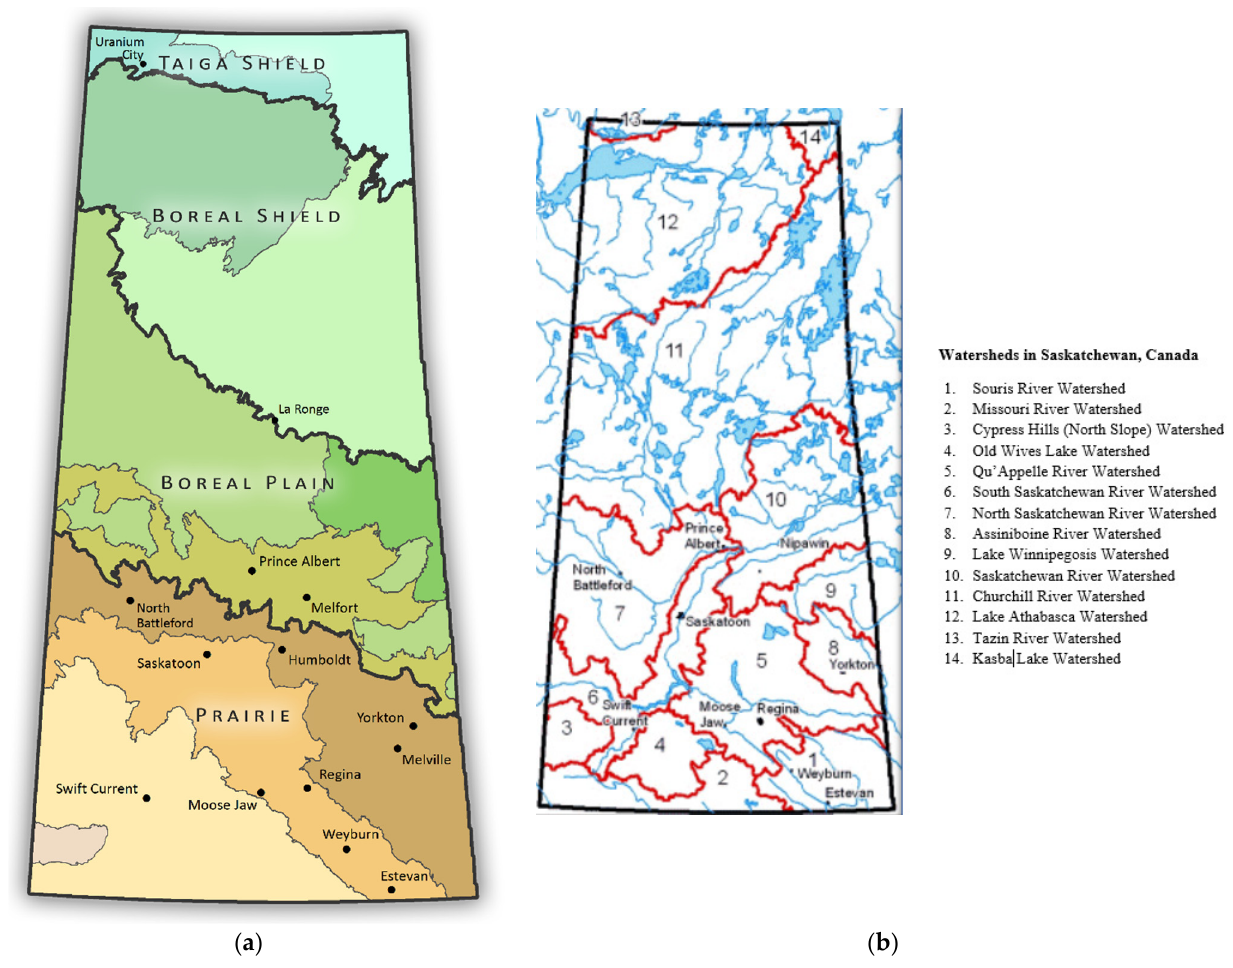
Figure 1. Maps of Saskatchewan ( a ) ecozones and ( b ) watersheds and water bodies [23,24].